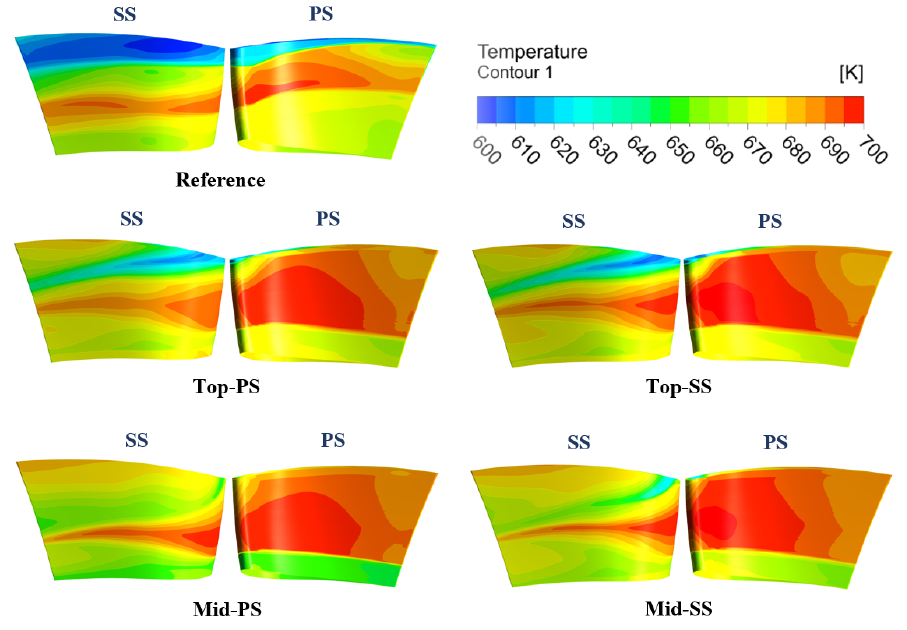
Figure 13. Temperature distribution on the S 2 vane surface.